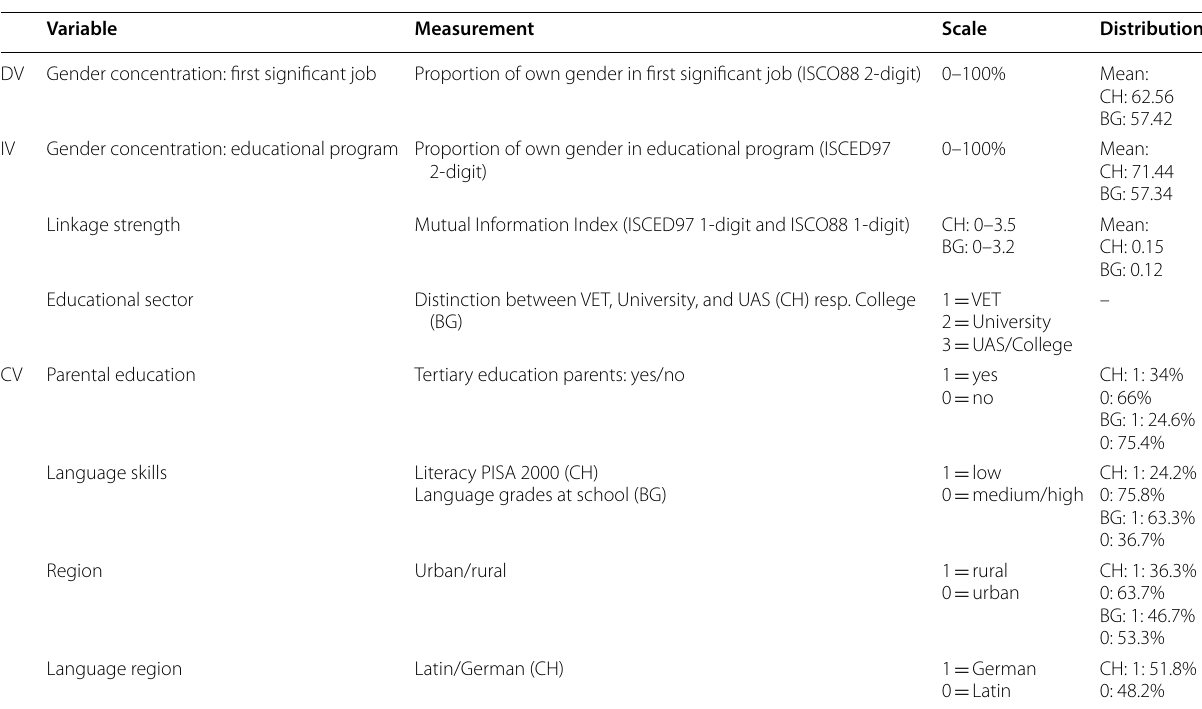
Table 1 Descriptive statistics of used variables. Source: Own calculations Variable